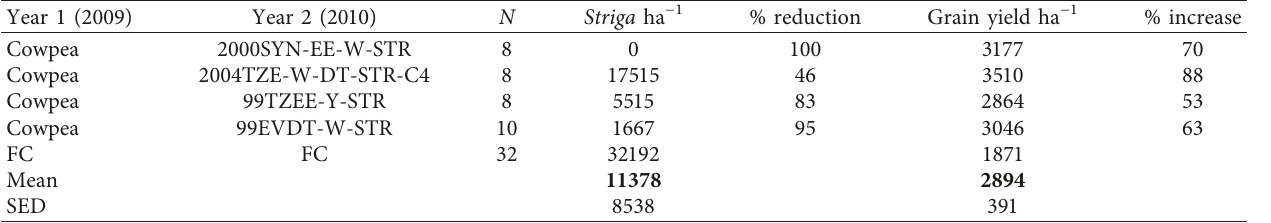
Table 1: Striga count ha − 1 and mean grain yield of different maize varieties following cowpea on farmers’ field in Sudan savannah.